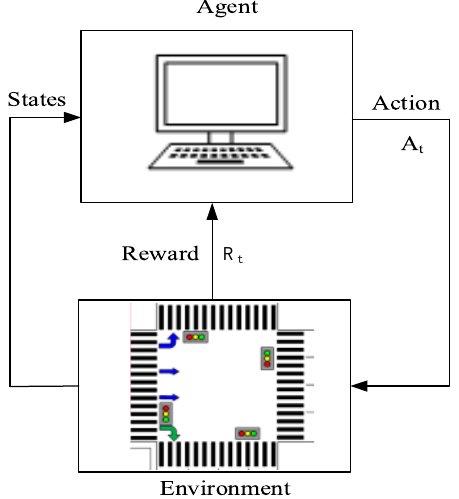
Figure 6. Framework of reinforcement learning. 415